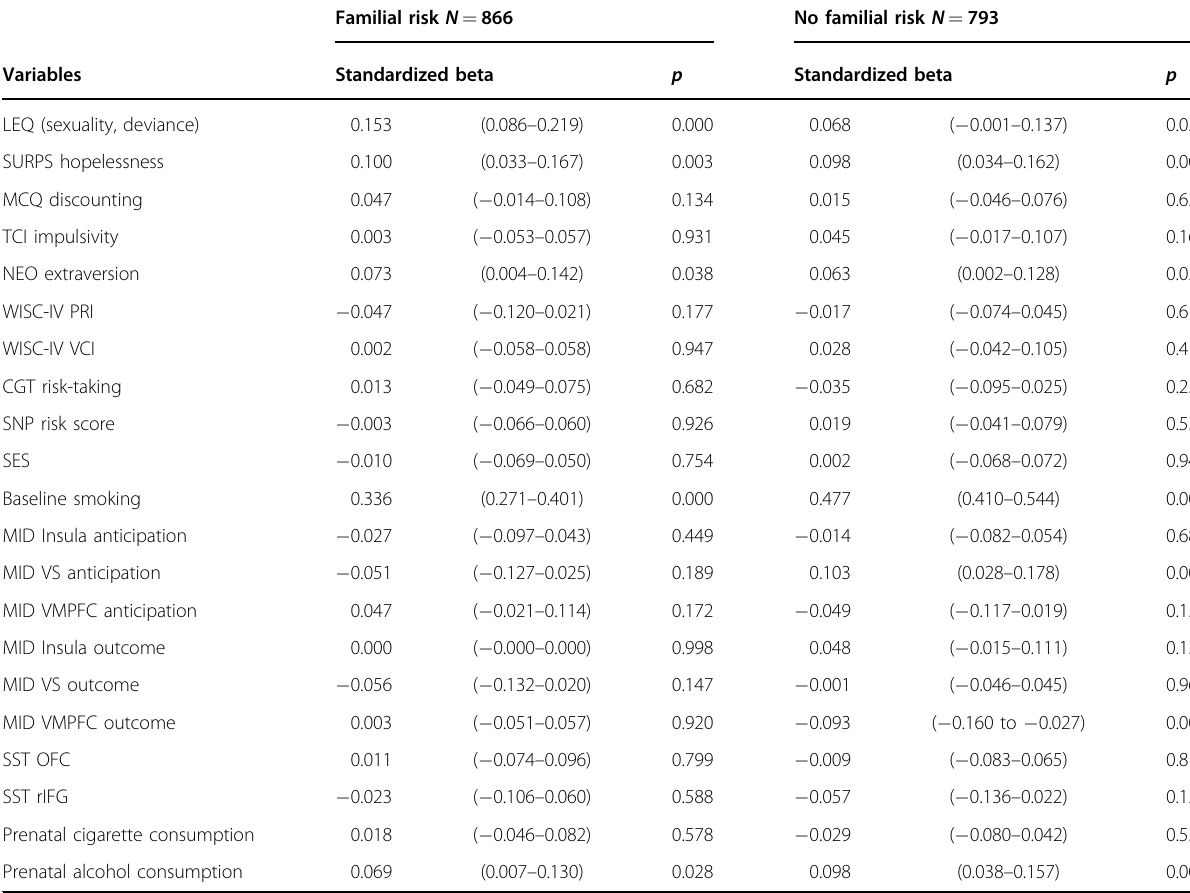
Table 3 Prediction of AUDIT scores at baseline as a function of familial